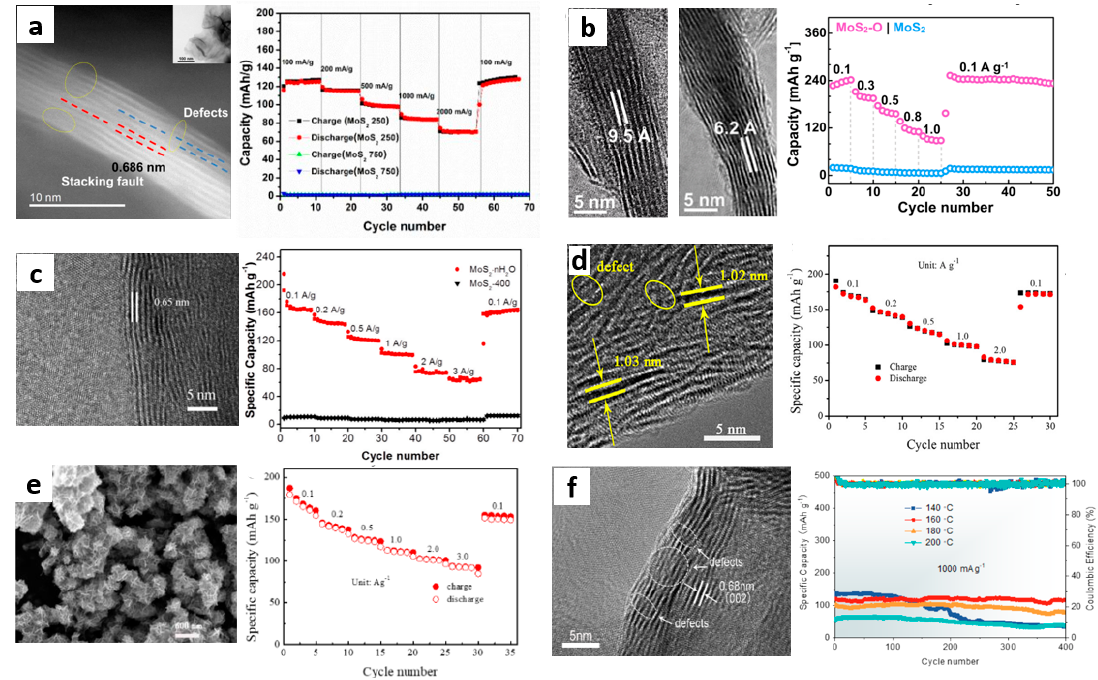
Figure 4. ( a ) HRTEM image of the defect − rich MoS 2 and its rate performance [38]; ( b ) HRTEM im ‐ ages of oxygen incorporated MoS 2 (left showing oxygen incorporated MoS 2 , right showing pristine MoS 2 ) and the rate performance of oxygen incorporated MoS 2 [40]; ( c ) HRTEM image of MoS 2 ∙ nH 2 O and the rate performance of Zn/MoS 2 ∙ nH 2 O batteries [41]; ( d ) HRTEM image of the MoS 2 /PANI − 150